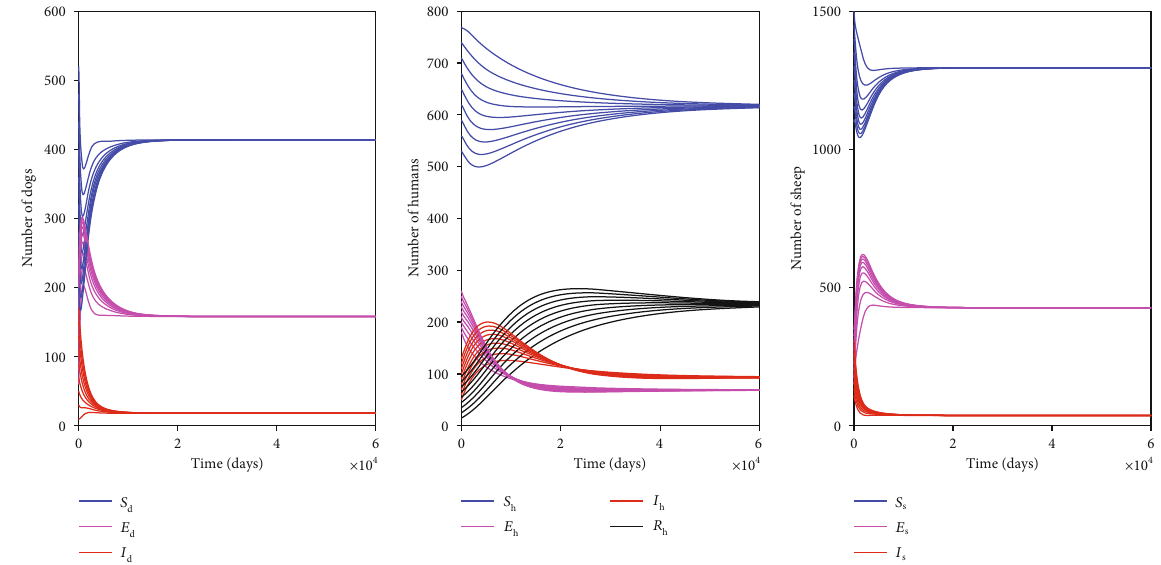
Figure 4: Time evolution of the dog, sheep, and human populations with baseline parameter values given in Table 3, using di ff erent initial conditions, except for β = 0 : 0001 , which gives R = 1 : 8 , and with approximate equilibrium values S ∗ 0 es E ∗ = 69 , I ∗ = 94 , R ∗ = 234 , S ∗ = 1296 , E ∗ = 427 , and I ∗ = 37 s s s h h h